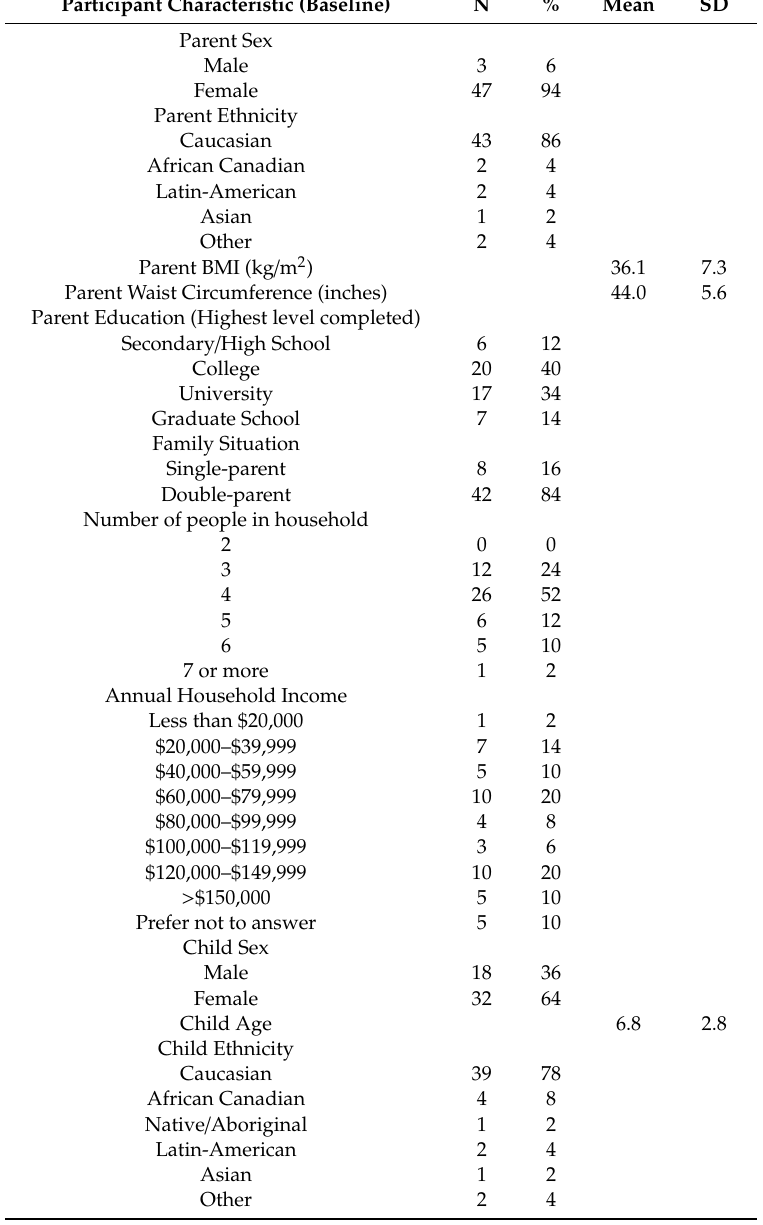
Table 2. Demographic Characteristics of Parent-Child